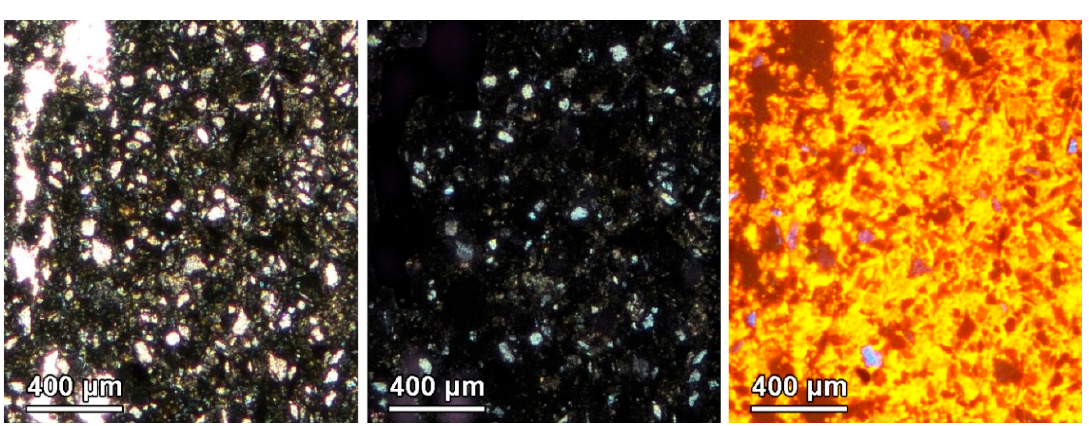
Figure 3. Petrographic images of a sample of an unsilicified carbonatic nodule from upper Morrot unit corresponding to macroscopic sample M2 (in Figure 5). Images include PPL (left), XPL (middle), and CL (right) micrographs of the same area. The presence of calcite cement is clearly seen by CL microscopy with its characteristic orange color.